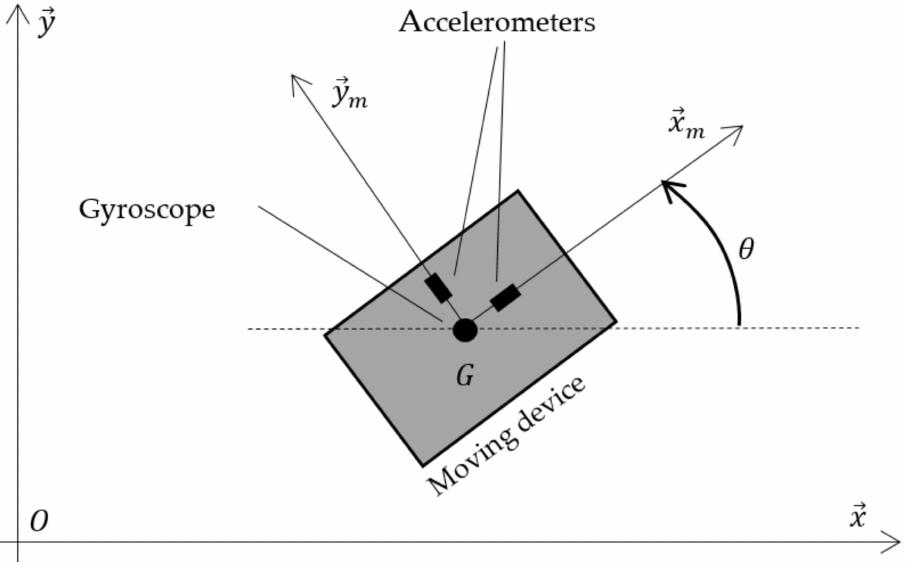
Figure 1. Moving device to track into an indoor